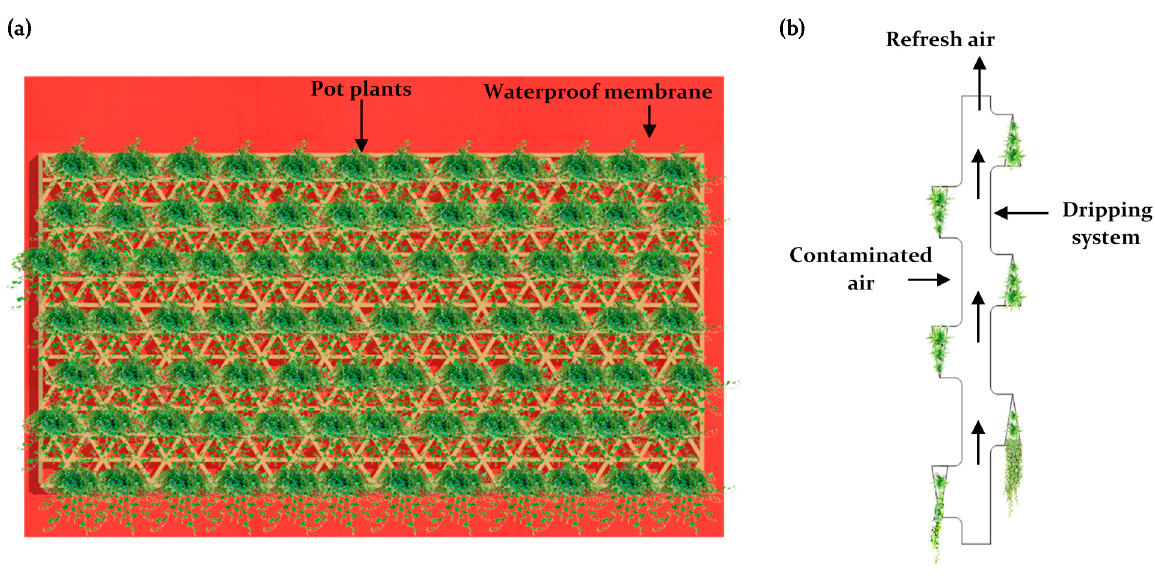
Figure 6. Retrofitting of green plants in a wall: ( a ) plan view and ( b ) sectional view.